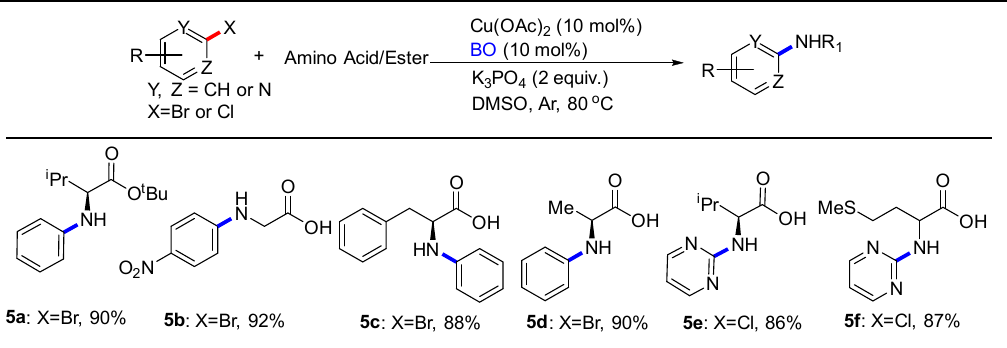
Table 4. C-N Coupling reactions of substituted aryl compounds with amino acids / esters a,b . Cu(OAc) 2 (10 mol%) ZY X BO (10 R Amino Acid/Ester+